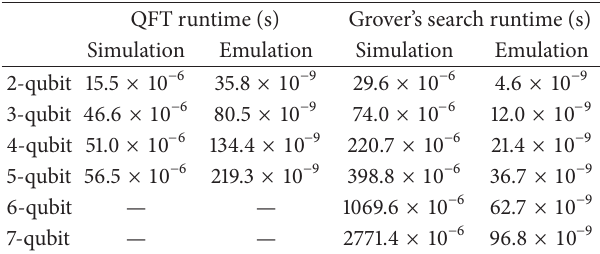
Figure 17: Resource utilization for different fixed point formats used.